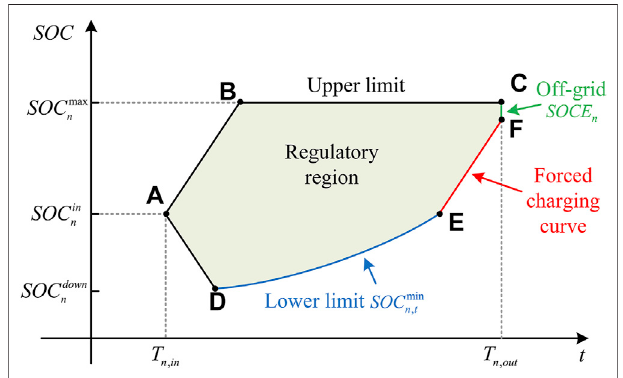
FIGURE 3 | SOC boundaries of a single